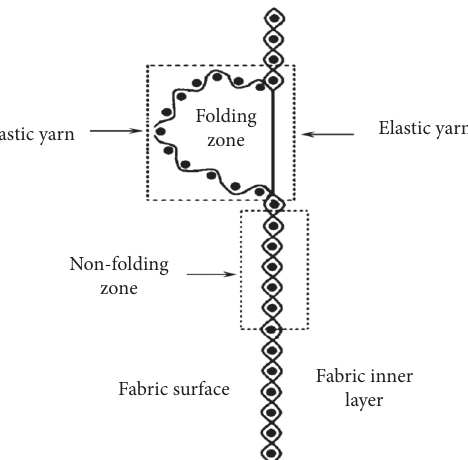
Figure 7: Schematic diagram of fabric warp fold